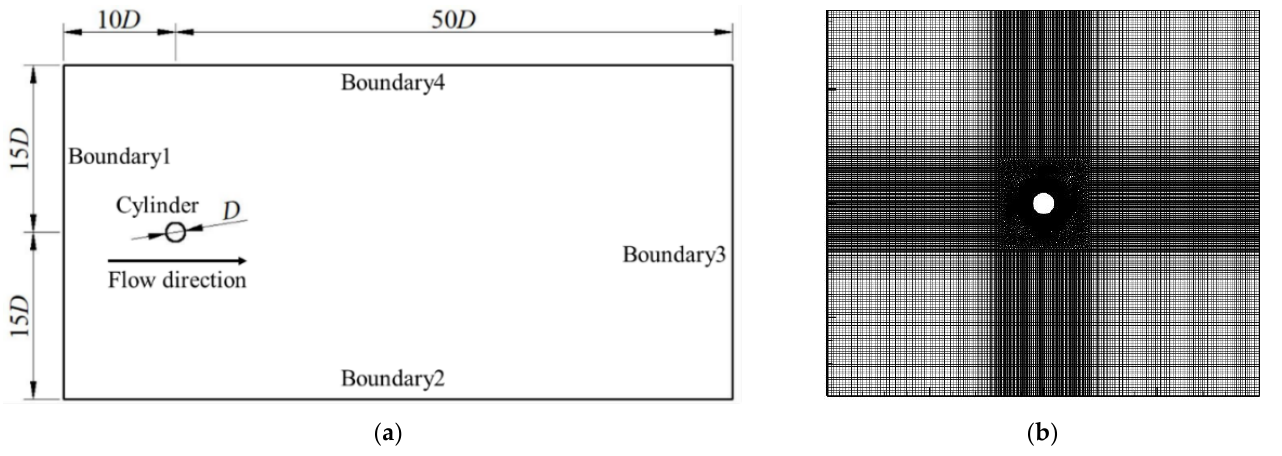
Figure 1. Computational model: ( a ) Computational domain; ( b ) Local grids.